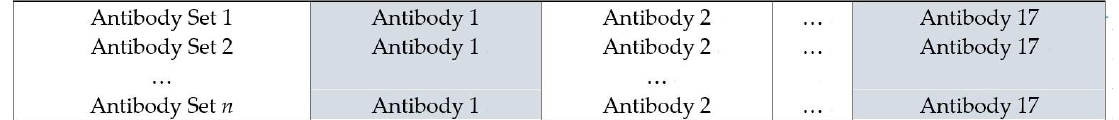
Figure 7. The computation flow of our AIS training algorithm. Figure 7. the computation flow of our AIS training algorithm.